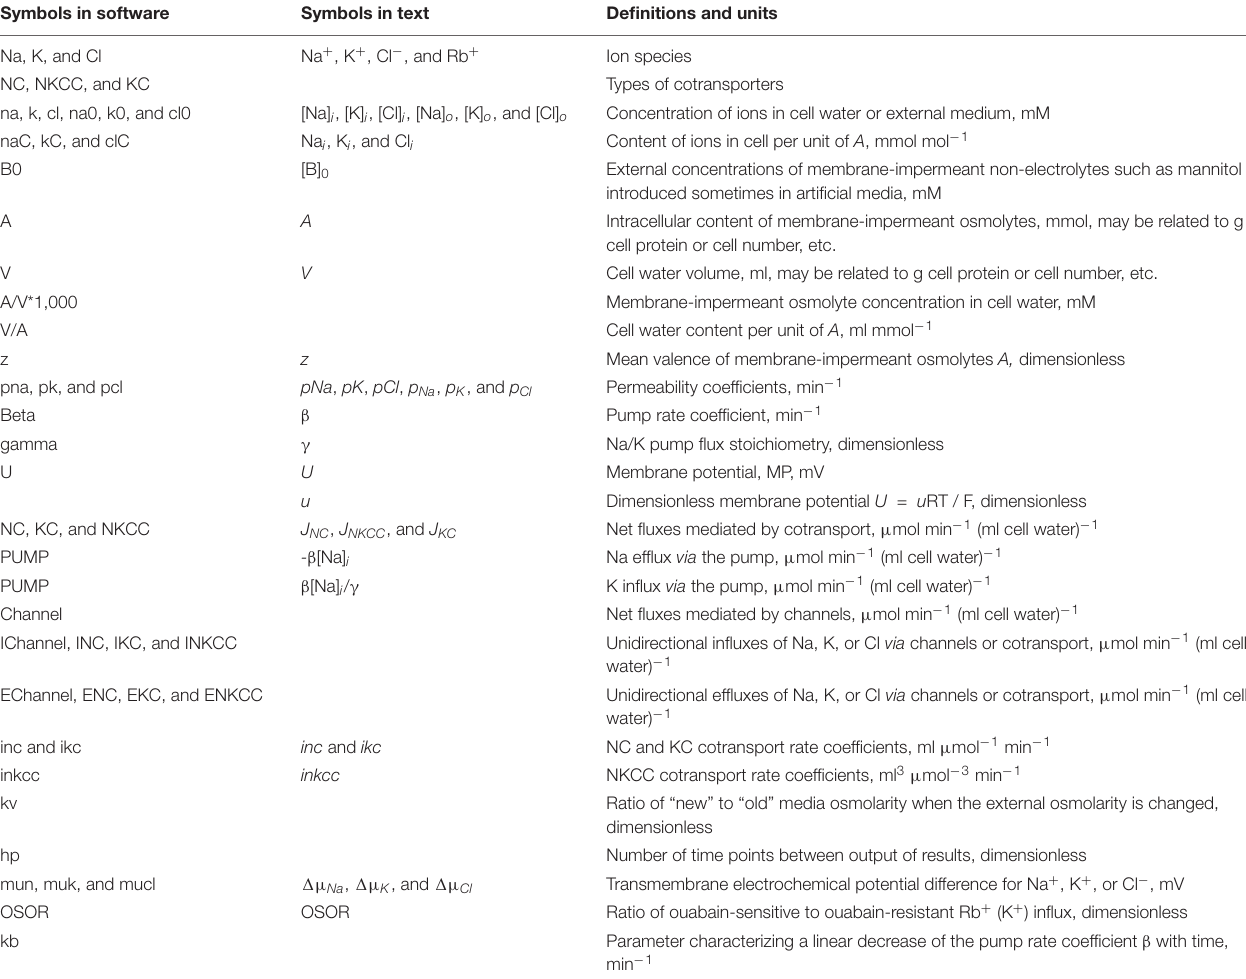
TABLE 1 | Symbols and definitions. Symbols in software Symbols in text Definitions and